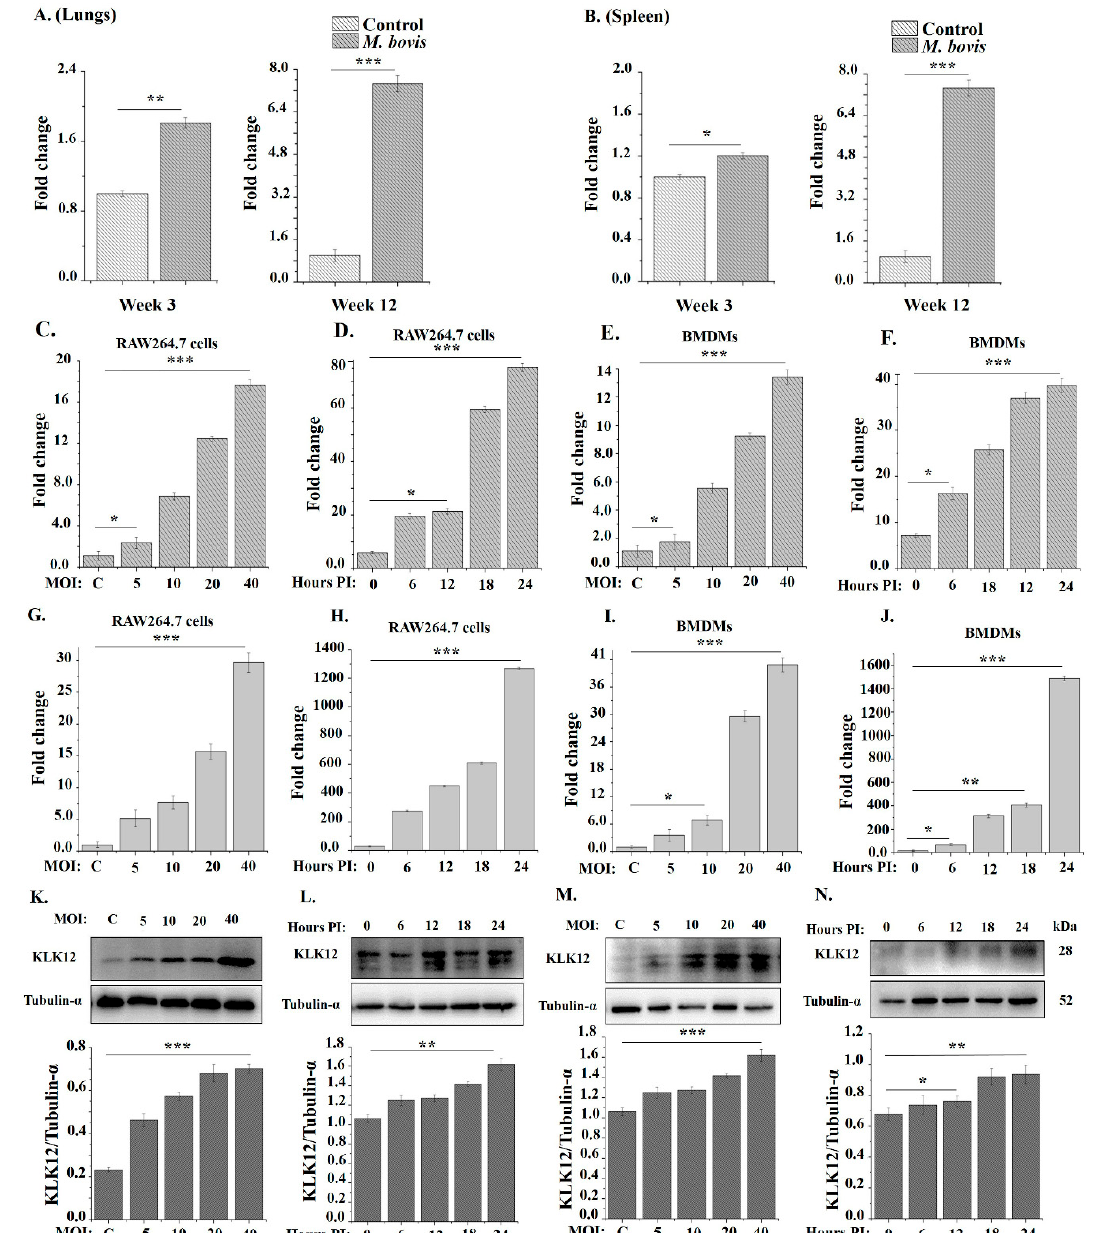
Figure 1. Mycobacterium bovis ( M. bovis ) infection upregulates KLK12 expression in mice and murine macrophages. ( A, B ) Mice ( n = 10) were intranasally infected with M. bovis C68004 (at a dose of 200 CFU / mouse) or with PBS. Mice were sacrificed after 3 and 12 weeks of infection, and lungs and spleens were collected. KLK12 expression was detected by Quantitative Real-Time PCR (qRT-PCR); ( C ) RAW264.7 cells were infected with M. bovis C68004 at a variable multiplicity of infection (MOI) (5, 10, 20 and 40) and incubated for 24 h; ( D ) RAW264.7 cells were infected with M. bovis C68004 at a MOI of 10 and incubated for indicated time periods, i.e., 0, 6, 12, 18 and 24 h; ( E ) BMDMs were infected with M. bovis C68004 at a variable multiplicity of infection (MOI) (5, 10, 20 and 40) and incubated for 24 h; ( F ) BMDMs were infected with M. bovis C68004 at a MOI of 10 and incubated for indicated time periods, i.e., 0, 6, 12, 18 and 24 h; ( G ) RAW264.7 cells were infected with M. bovis N strain at a variable multiplicity of infection (MOI) (5, 10, 20 and 40) and incubated for 24 h; ( H ) RAW264.7 cells were infected with M. bovis N strain at a MOI of 10 and incubated for indicated time periods, i.e., 0, 6, 12, 18 and 24 h; ( I ) BMDMs were infected with M. bovis N strain at a variable multiplicity of infection (MOI) (5, 10, 20 and 40) and incubated for 24 h; ( J ) BMDMs were infected with M. bovis N strain at a MOI of 10 and incubated for indicated time periods, i.e., 0, 6, 12, 18 and 24 h. In all these groups, KLK12 expression was determined by qRT-PCR; ( K ) BMDMs were infected with M. bovis C68004 at a